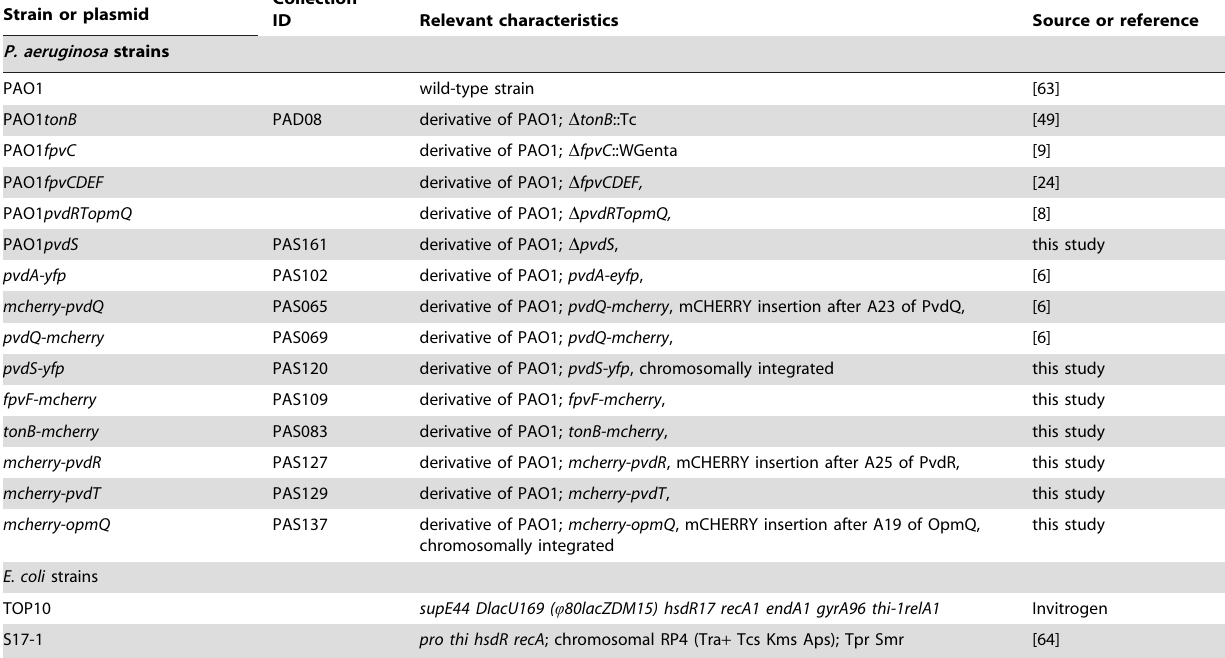
Table 1. Strains used in this